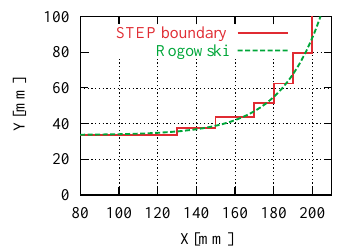
FIG. 3. (Color) Rogowski curve and simulating step